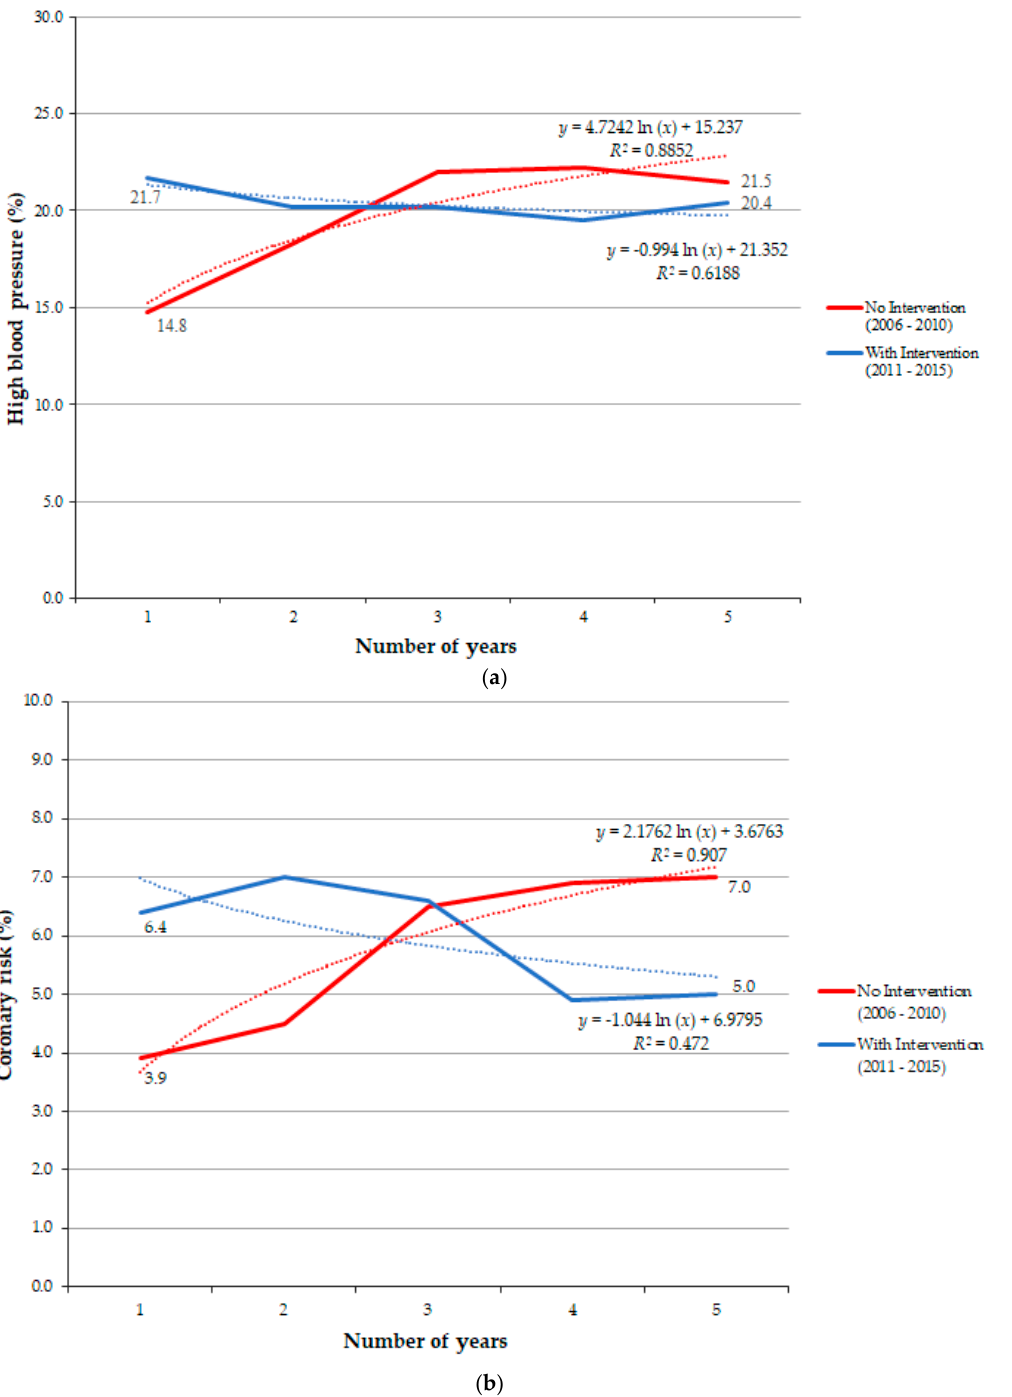
Figure 2. Prediction trend lines corresponding to indicators in which no improvements were observed ( a ) evolution of the high blood pressure indicator, ( b ) evolution of the coronary risk indicator.